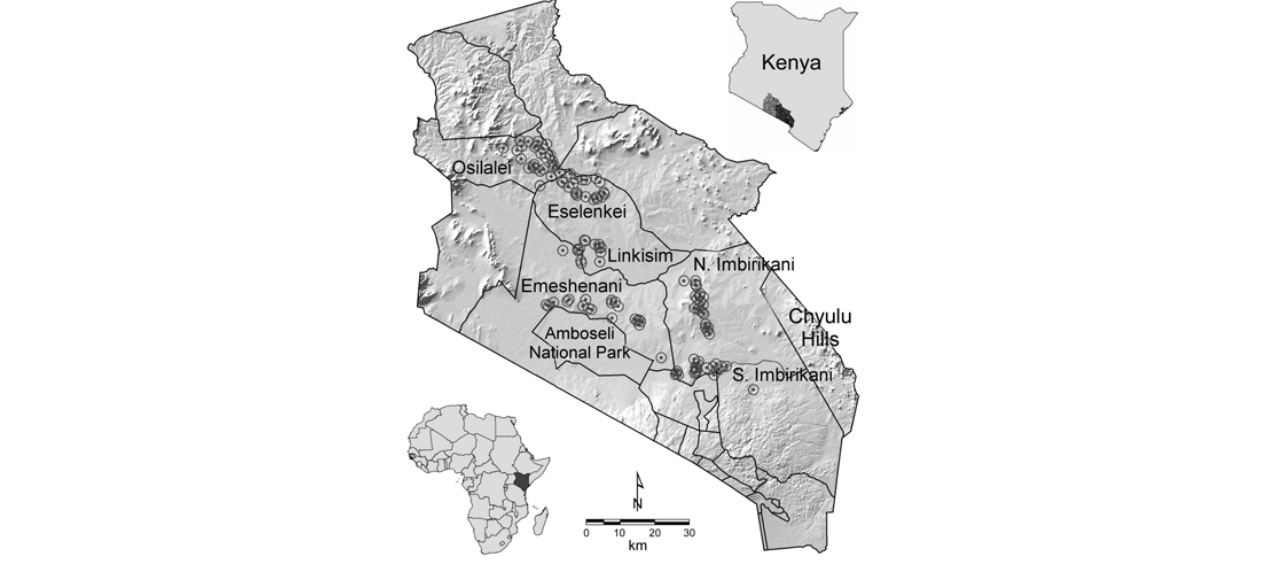
Fig. 1 . Southern Kajiado District, Kenya, with the six study areas labeled, as well as Amboseli National Park and the Chyulu Hills. Locations of the 184 households surveyed are marked with open circles. Topography is shown in gray, from the Shuttle Radar Topography Mission, and the location of Kajiado District within Kenya and Africa is shown in the